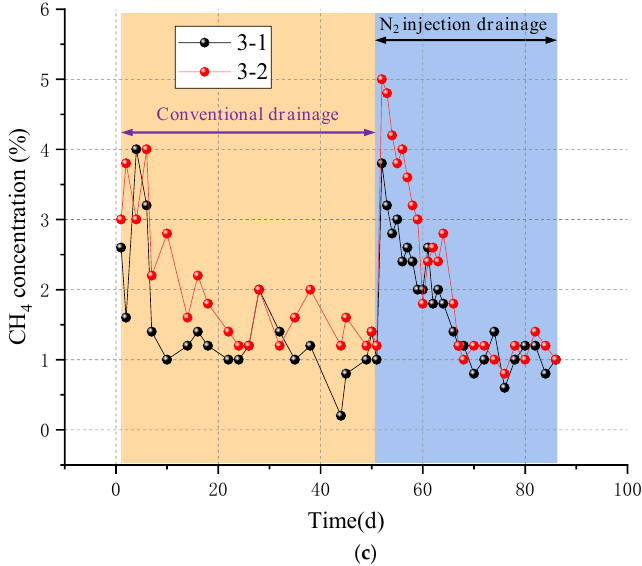
Figure 9. CH 4 concentration of drainage boreholes with respect to time: ( a ) Group 1 (Injection pressure is 1.2 MPa); ( b ) Group 2 (Injection pressure is 0.8 MPa); ( c ) Group 3 (Injection pressure is 0.4 MPa).